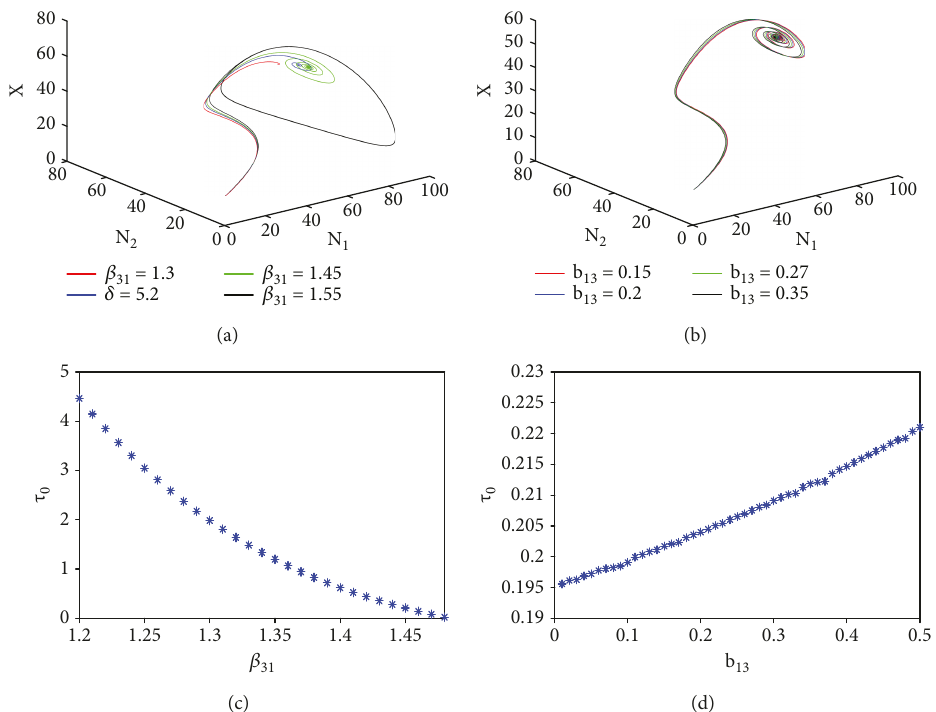
31 and (b) b 13 . Relation between the critical value of time delay